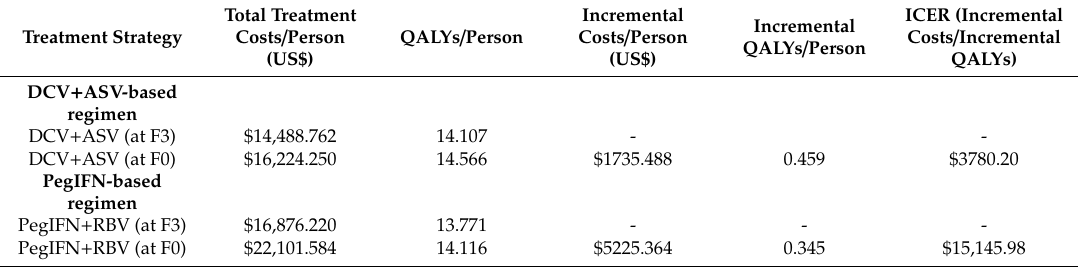
Table 2. Costs, QALY, and ICER of Early treatment at stage F0 compared with delayed to F3 stage under DCV + ASV and PegIFN-based